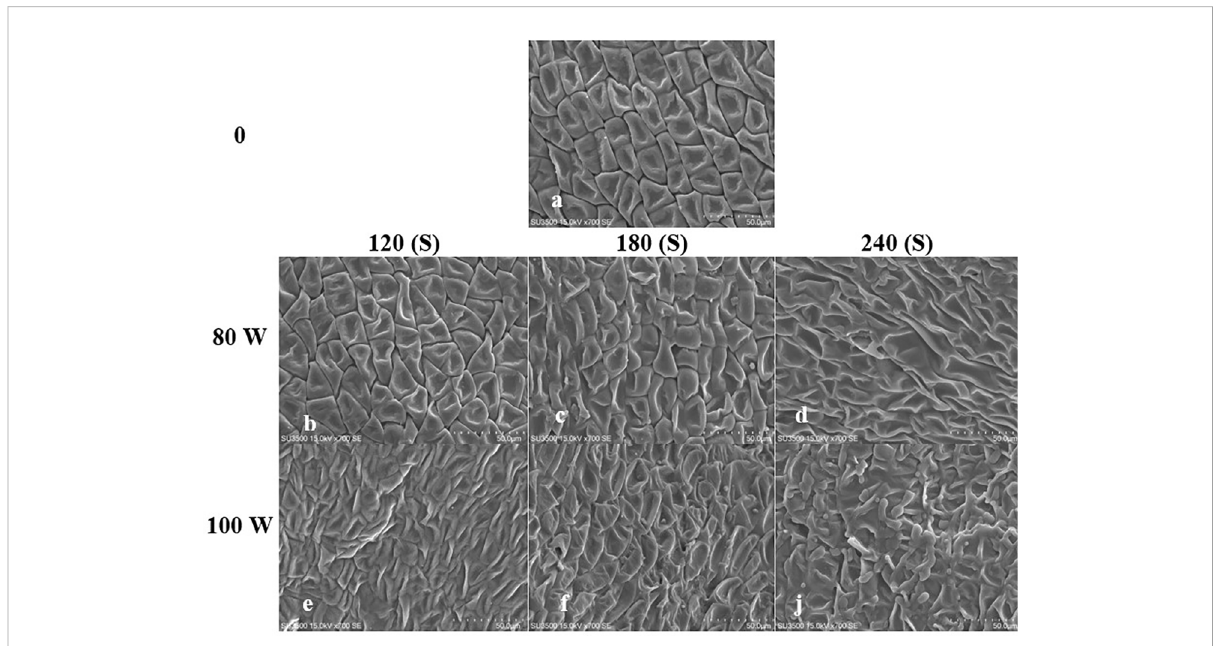
FIGURE 4 Scanning Electron Microscope (SEM) images of the uncovered seed (US) surface of S. leriifolia under cold plasma. (A) uncovered seeds (US), (B) US in 80 W 120s, (C) US in 80 W 180s, (D) US in 80 w 240s, (E) US in 100 W 120s, (F) US in 100 W 180s, (J) US in 100 W 240s.